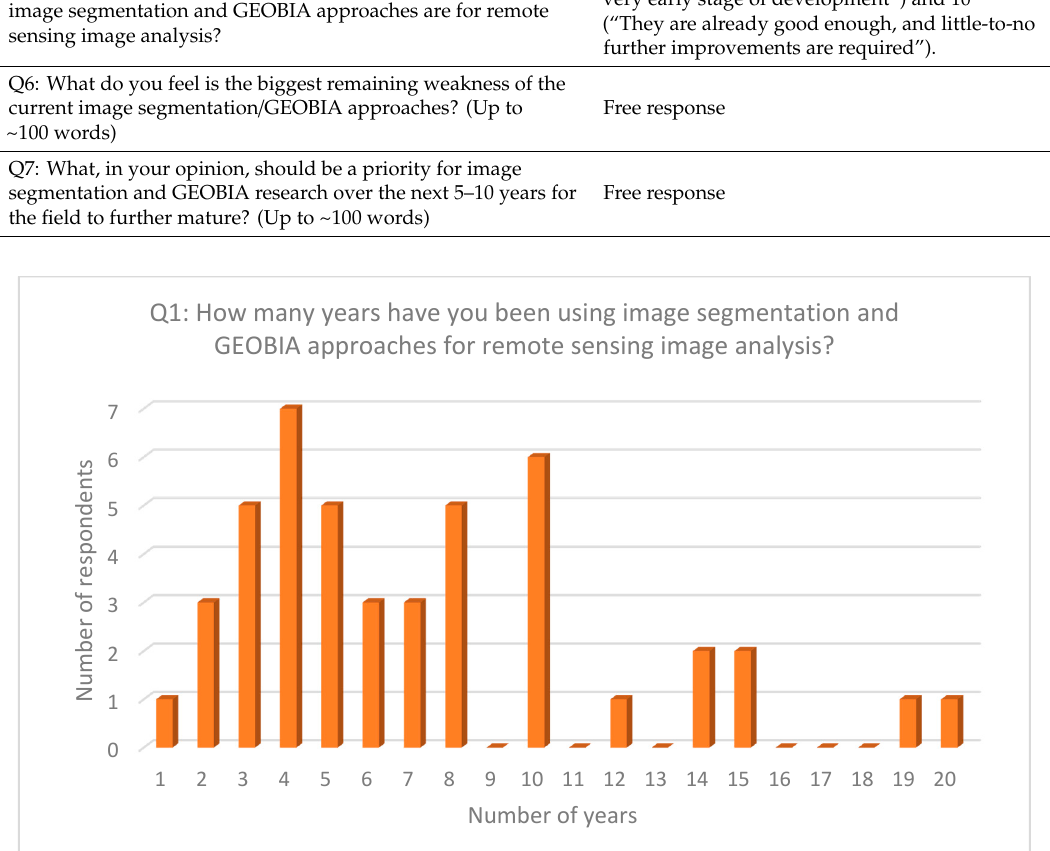
Figure 2. Responses to question 1 (Q1) of the online survey.